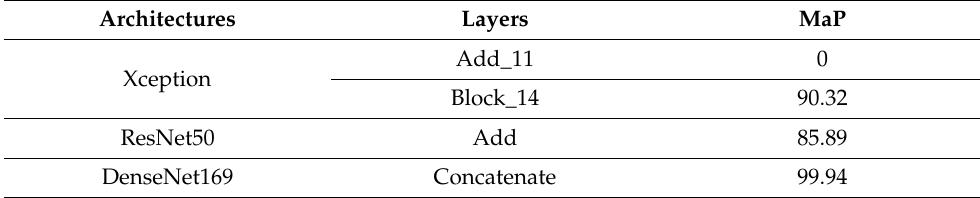
Table 5. MaP with RMAC layer after new position (%) in complex